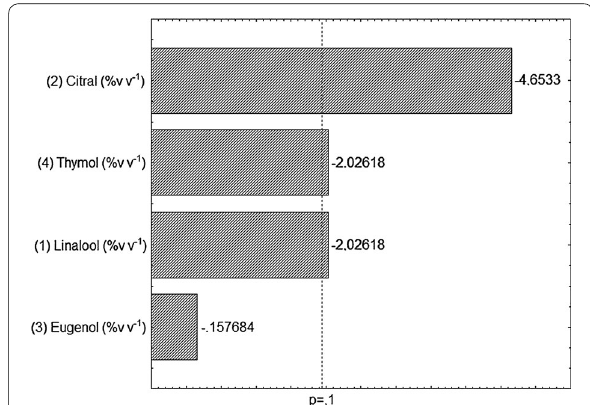
Fig. 2 Pareto chart with estimated effect (absolute value) of the studied variables in the PB 8 experimental design for growth control of S. flexneri